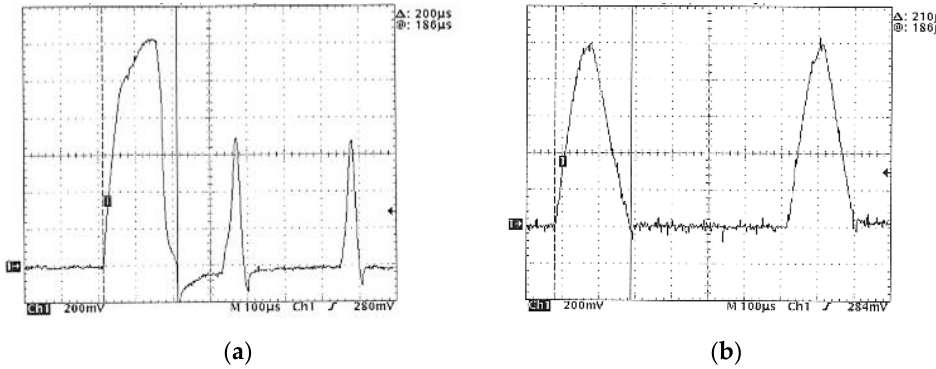
Figure 11. Impulses with a frequency of ( a ) around 3 kHz–problems on the second and third pulses ( b ) around 1.5 kHz–both pulses represented has similar behavior.